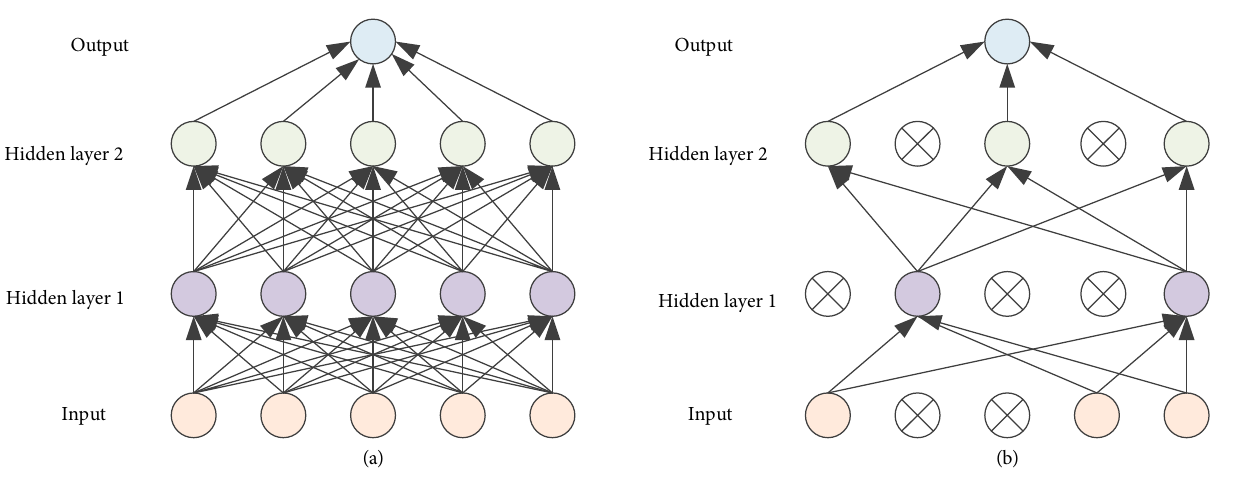
Figure 13: A standard neural network model (a) and a network model with dropout (b)